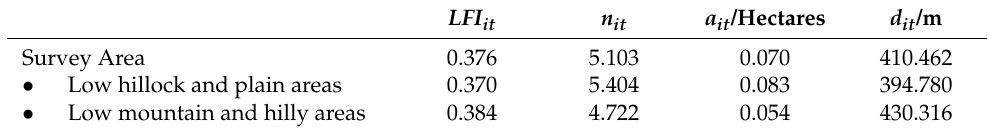
Table 2. Regional distribution of LF degree in different landform types.